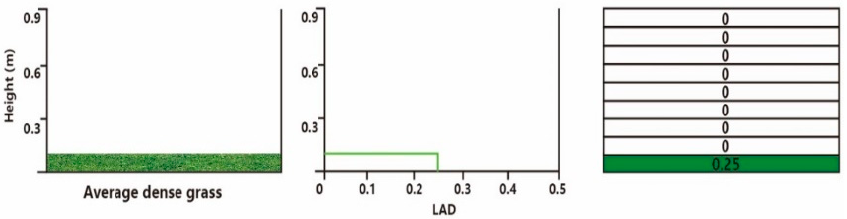
Figure 10. Schematic of the grass database model for ENVI-met.